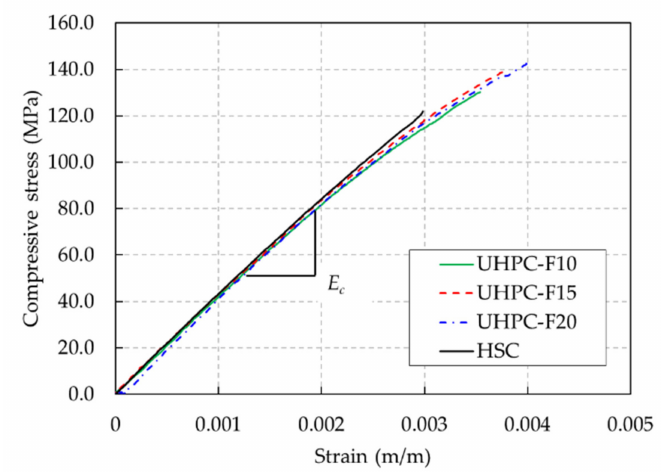
Figure 2. Compressive stress-strain curves of the HSC and UHPC